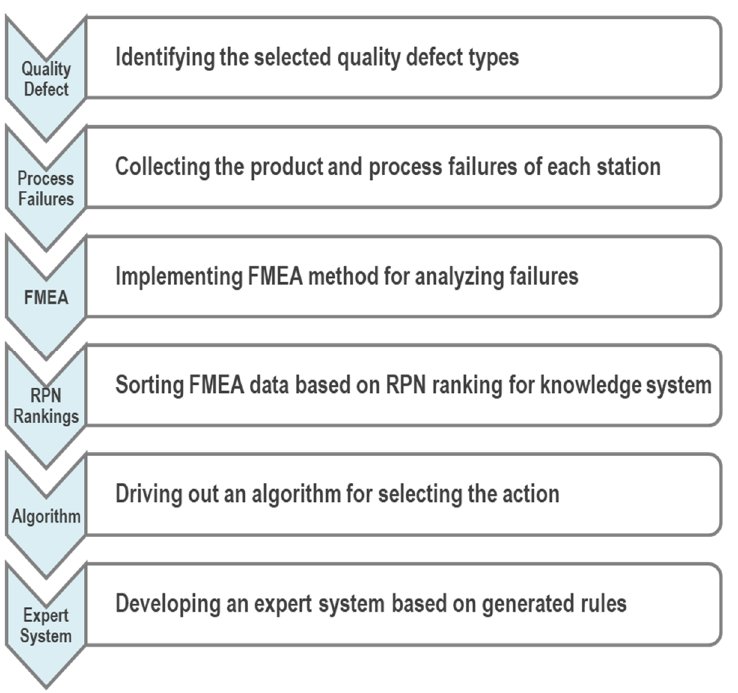
Figure 1. Systematic procedure for carrying out the research.